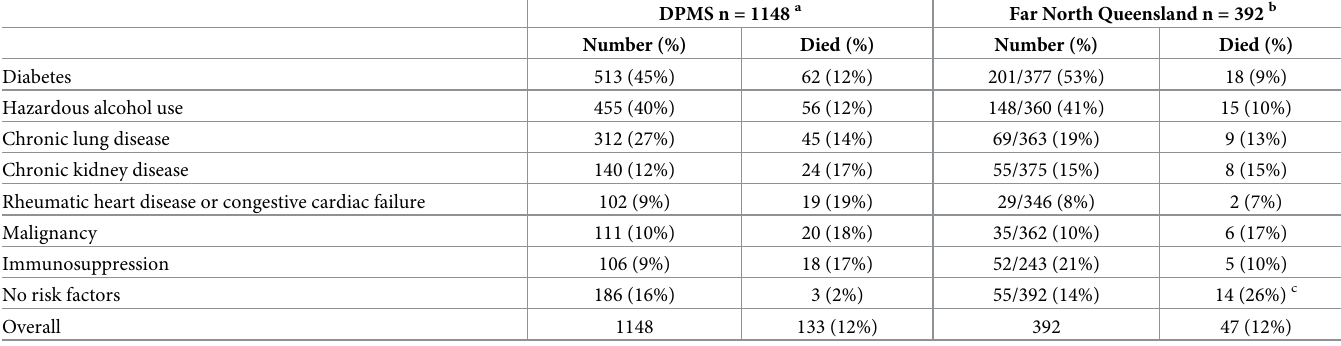
Table 2. Comparison of the proportion of melioidosis cases with the different predisposing risk factors in the Darwin Prospective Melioidosis Series (DPMS) and Far North Queensland